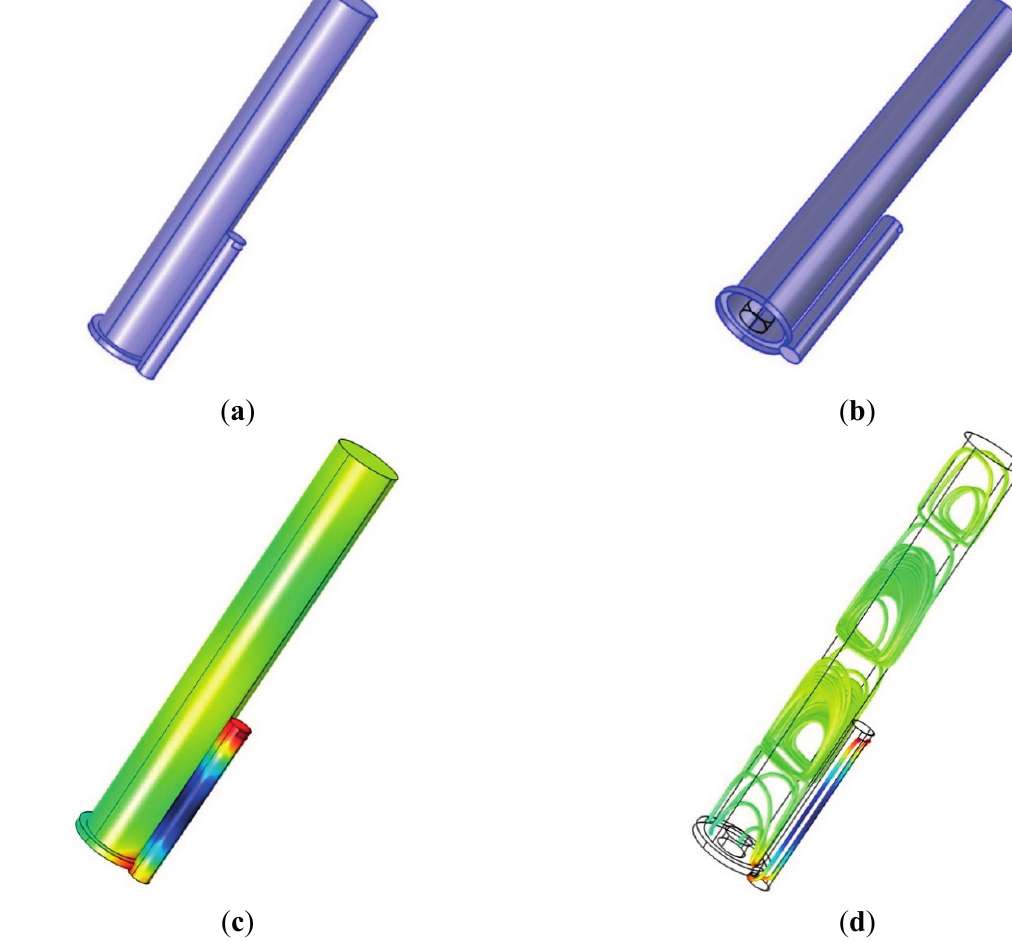
Figure 10. Simulation with NFML structure with single directional pipe: ( a ) physical structure (center pipe dimension: l = 192.1 mm and d = 27.8 mm; directional pipe dimension: l = 78.4 mm and d = 10 mm); ( b ) at the bottom of the NFML structure, the transparent cylinder indicates the microphone; ( c ) sound pressure distribution at 3014.6 Hz and ( d ) RMS sound intensity streamline at 3014.6